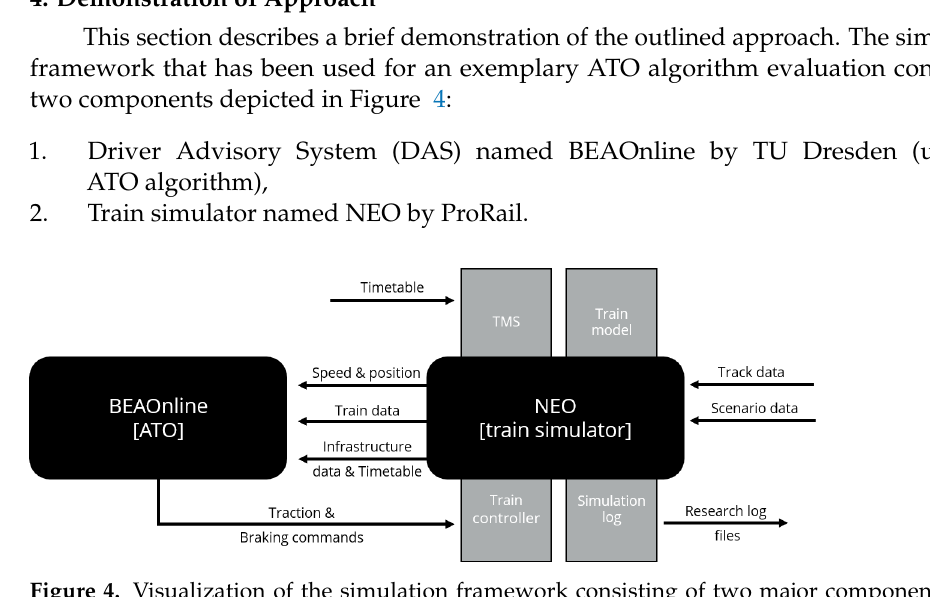
Figure 4. Visualization of the simulation framework consisting of two major components (train simulator and ATO algorithm), their subparts and the data exchange between